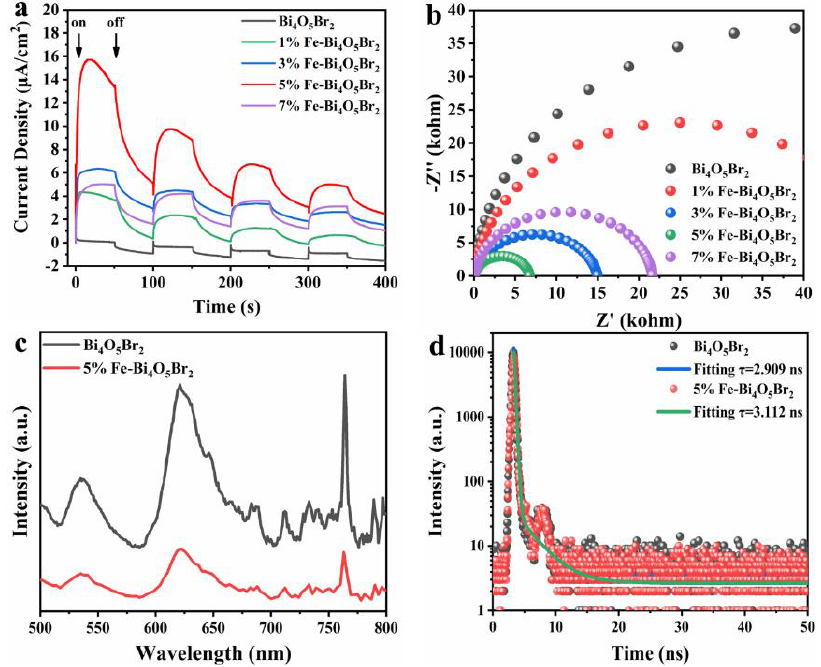
Figure 6. ( a ) Transient photocurrent response of samples, ( b ) EIS Nyquist plots, ( c ) PL spectra of Bi 4 O 5 Br 2 and 5%Fe-Bi 4 O 5 Br 2 and ( d ) TRPL spectra of Bi 4 O 5 Br 2 and 5%Fe-Bi 4 O 5 Br 2 . The recombination kinetics of photogenerated carriers can be comprehensively sim- ulated by the measurement of fluorescence spectra. In the steady-state photoluminescence (PL) spectra (Figure 6c), 5%Fe-Bi 4 O 5 Br 2 responds with a weaker fluorescence intensity compared to Bi 4 O 5 Br 2 upon excitation at a 375 nm exciting light source. The result indi- cated that the recombination of photogenerated carriers was inhibited in 5%Fe-Bi 4 O 5 Br 2 , which is consistent with the result observed in the photocurrent. In addition, the average fluorescence lifetime (τ) of photogenerated carriers is evaluated in the time − resolved pho- toluminescence spectra (TRPL). As shown in Figure 6d, the τ value of 5% Fe-Bi 4 O 5 Br 2 is 3.112 ns, which is effectively extended than that of Bi 4 O 5 Br 2 (2.909 ns), suggesting that facilitated carriers with longer residence time are generated in the sample. These results further demonstrated that the photogenerated carriers can be effectively separated and transferred driven by the built − in electron field enhanced by 5%Fe-Bi 4 O 5 Br 2 . 3.2. Degradation Performance of TC The photocatalytic activities of the Bi 4 O 5 Br 2 and Fe-Bi 4 O 5 Br 2 samples were investi- gated by the degradation of TC under visible-light irradiation. As shown in Figure 7a, it is clear that almost no loss of TC in the absence of the photocatalyst in the control experi- ment can be observed, which confirmed that the degradation of TC is entirely derived from the action of the photocatalysts. Moreover, a dark treatment for 1 h is enough for the TC to reach an adsorption – desorption equilibrium on the surface of all the samples. The 5%Fe-Bi 4 O 5 Br 2 sample shows the strongest adsorption for TC, almost three times as much as Bi 4 O 5 Br 2 , which is attributed to a larger specific surface area exposing more adsorption sites. Significantly, 5%Fe- Bi 4 O 5 Br 2 possesses the best photocatalytic degradation activity for TC under visible-light irradiation for 3 h, reaching 60%. However, a further increase in the amount of the dopant into Bi 4 O 5 Br 2 induces an adverse effect on the photocatalytic performance. It can be observed that the photocatalytic activity of 7%Fe-Bi 4 O 5 Br 2 for the removal of TC decreases to only 28.9%, even worse than that of pure Bi 4 O 5 Br 2 (46.6%). Therefore, the appropriate ratio of Fe doping can induce the spontaneous polarization and